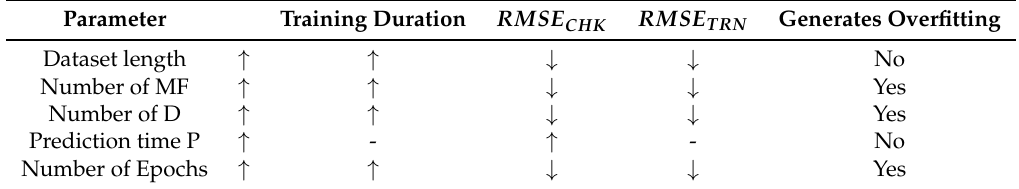
Table 3. Relationship between different parameters, ANFIS training duration, and performance.